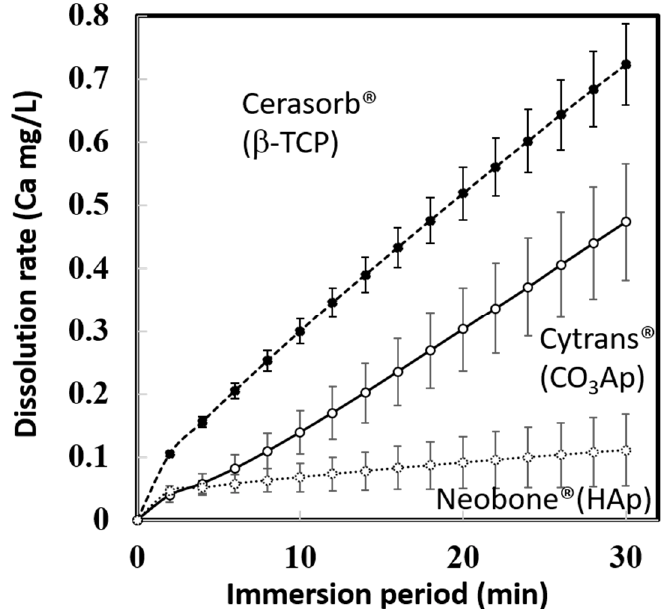
Figure 4. Dissolution behavior of Neobone ® (HAp), Cytrans ® (CO 3 Ap), and Cerasorb ® ( β -TCP) in CaPO 4 -free pH 7.3 buffer solution.